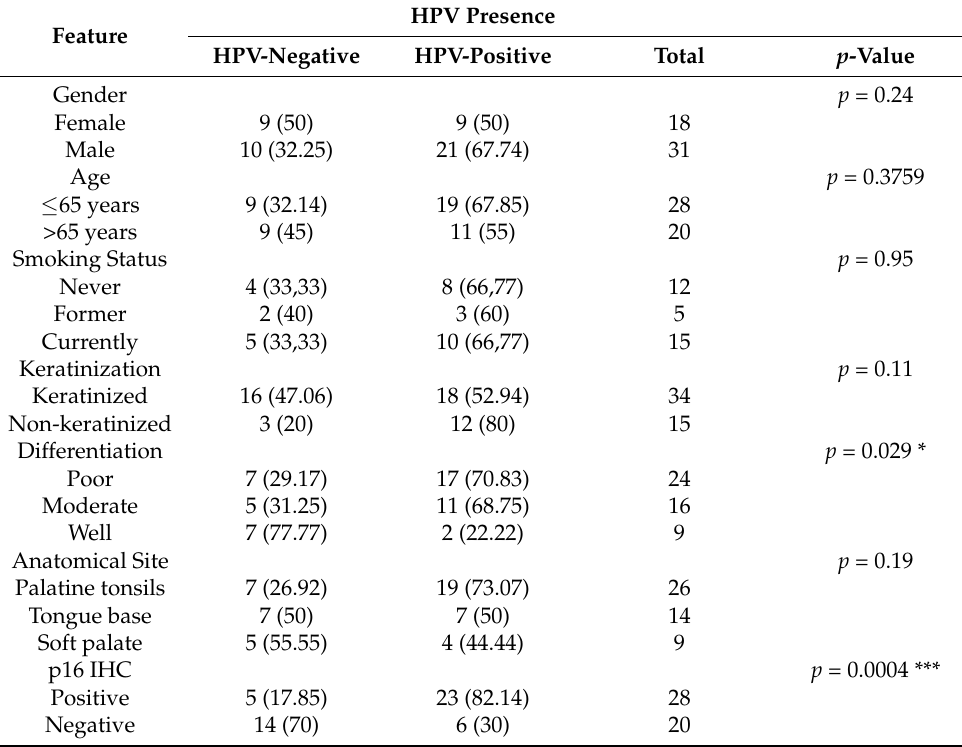
Table 3. Relationship between clinicopathological features of OPSCCs and HPV